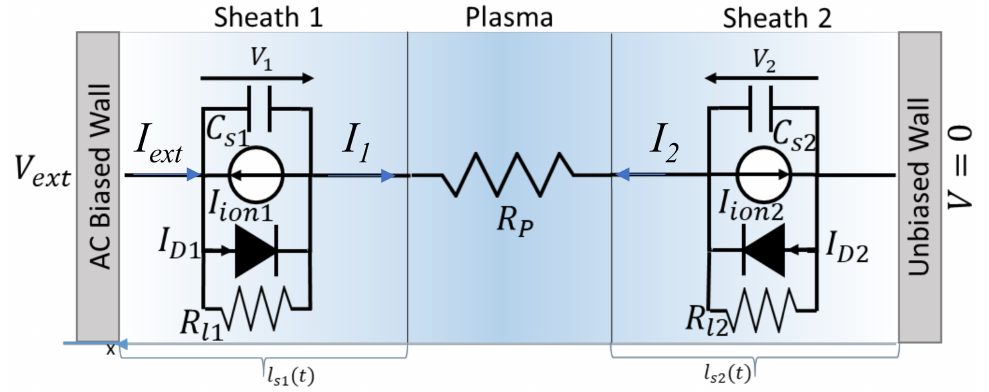
Figure 1. Equivalent circuit of a plasma between two